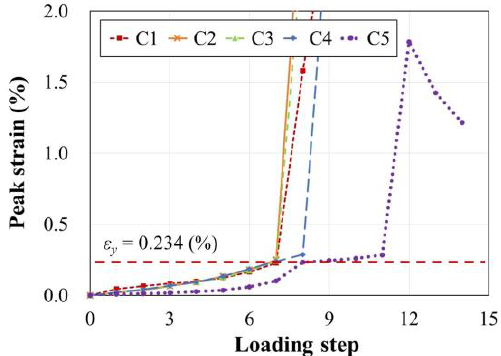
Figure 7. Peak strains in longitudinal